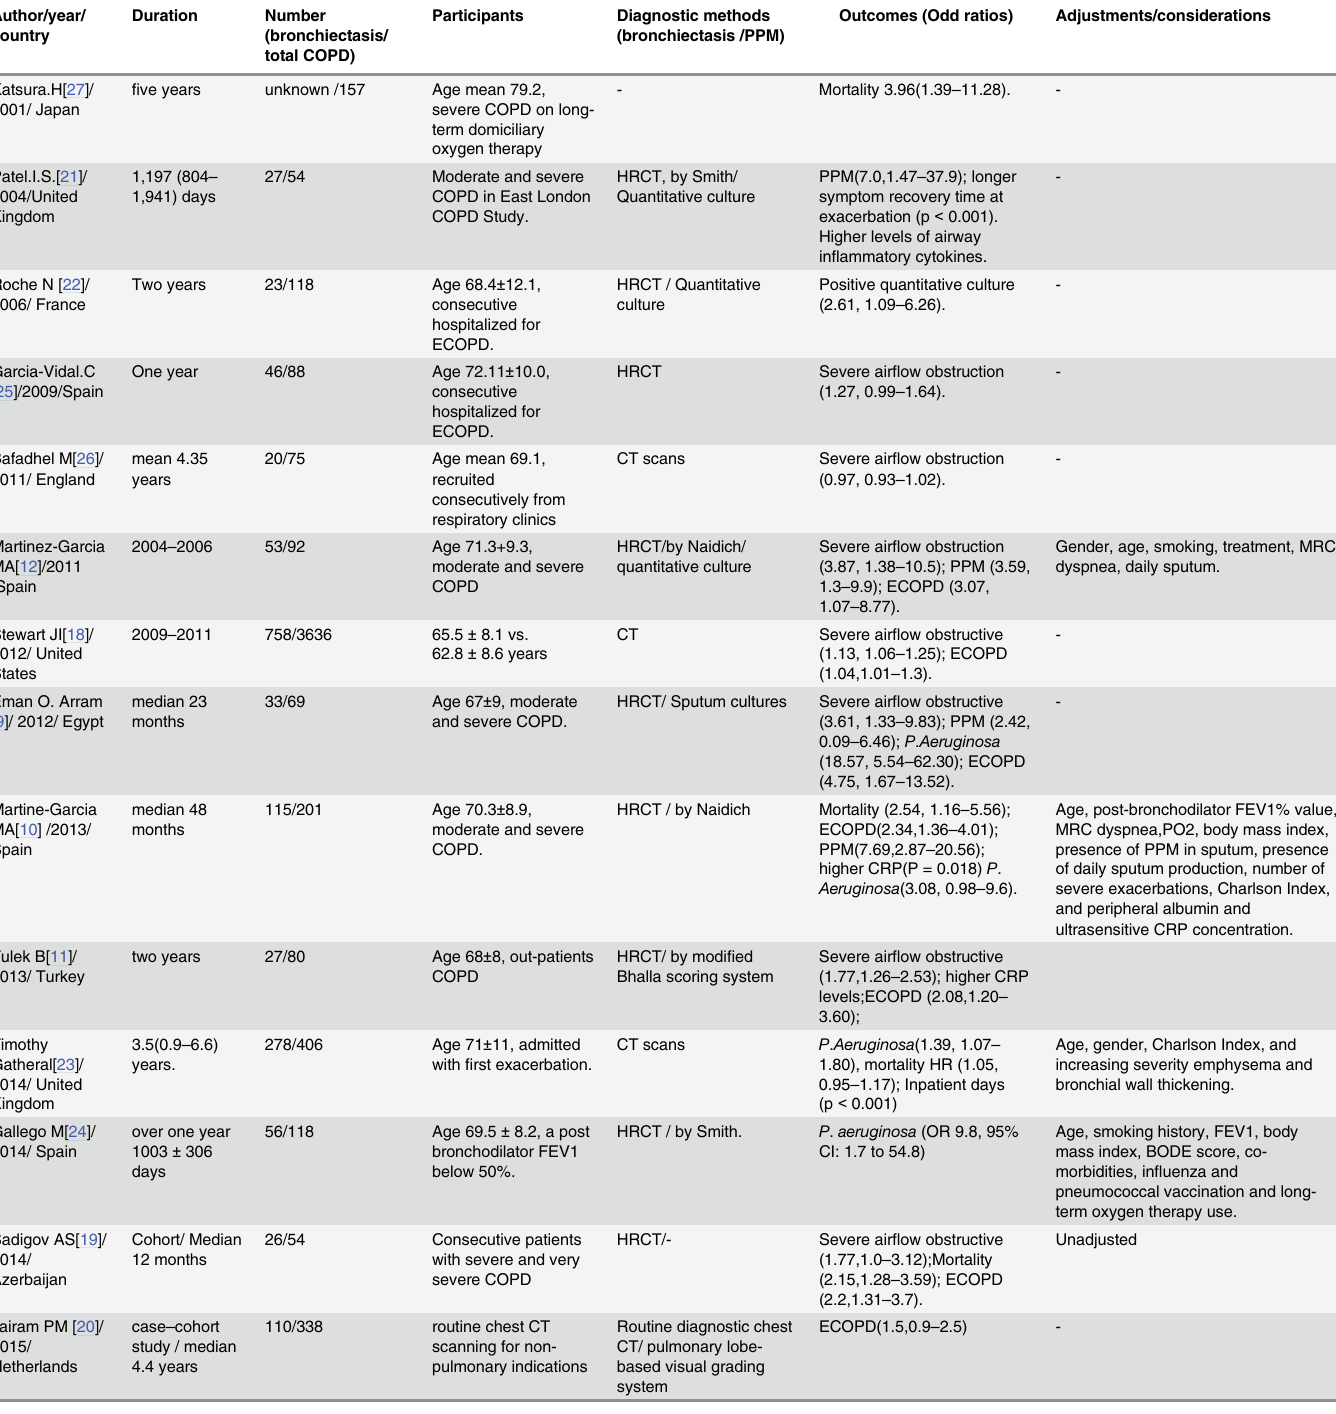
Table 1. Characteristics of Included Studies in the